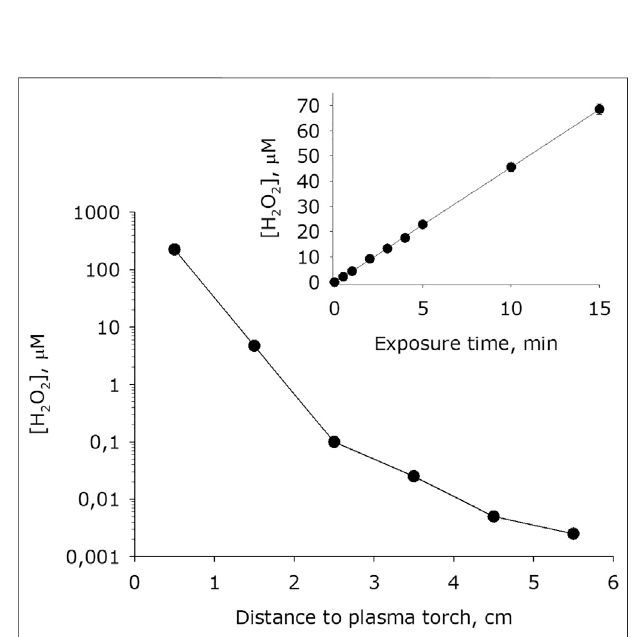
FIGURE 8 | Dependence of hydrogen peroxide concentration formed in water on distance from water surface to the plasma jet nozzle at 1 min of plasma exposure. Data are presented as mean standard error for three independent experiments. Inset shows dependence of hydrogen peroxide concentration formed in water on the time of plasma treatment at 1.5 cm distance from water surface to the plasma jet nozzle. The data are presented as average values with standard deviation of three experiment